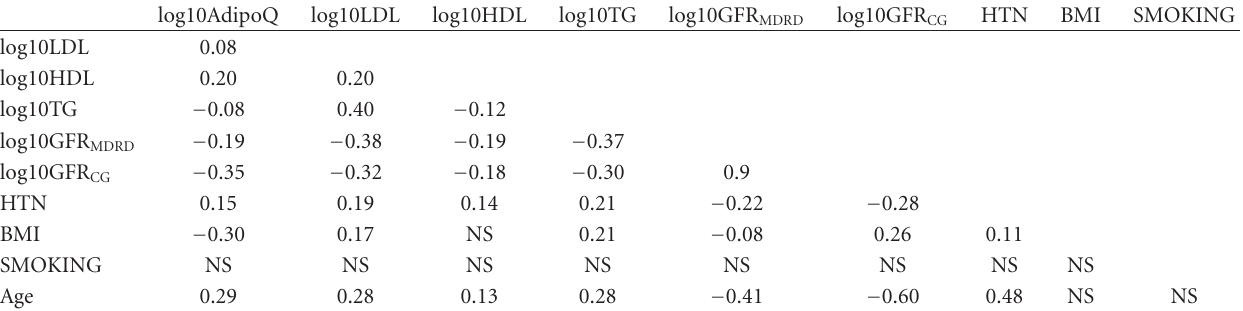
Table 2: Pearson’s coe ffi cients of correlation ( r p ) between eGFR MDRD or eGFR CG , adiponectin and other confounders adjusted for